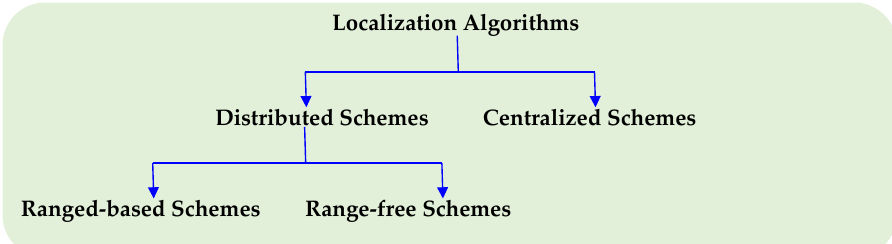
Figure 1. Classification of wireless sensor localization